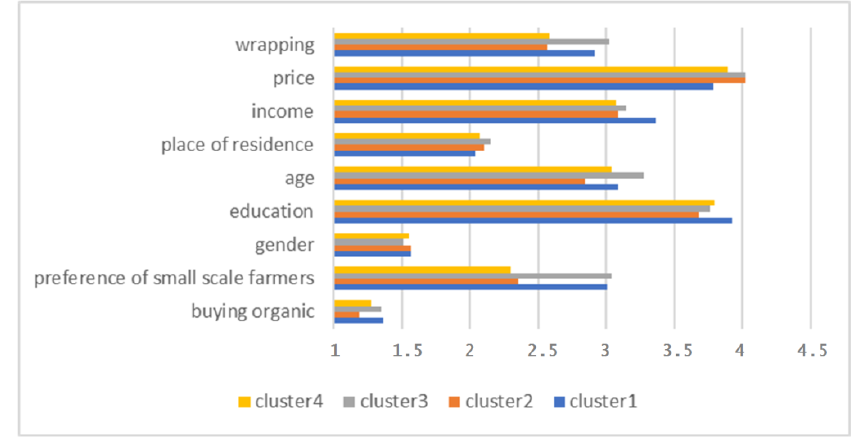
Figure 3. Demographic characteristics of the clusters. Gender: 1 — male; 2 — female; income 1 – 5, 3 was